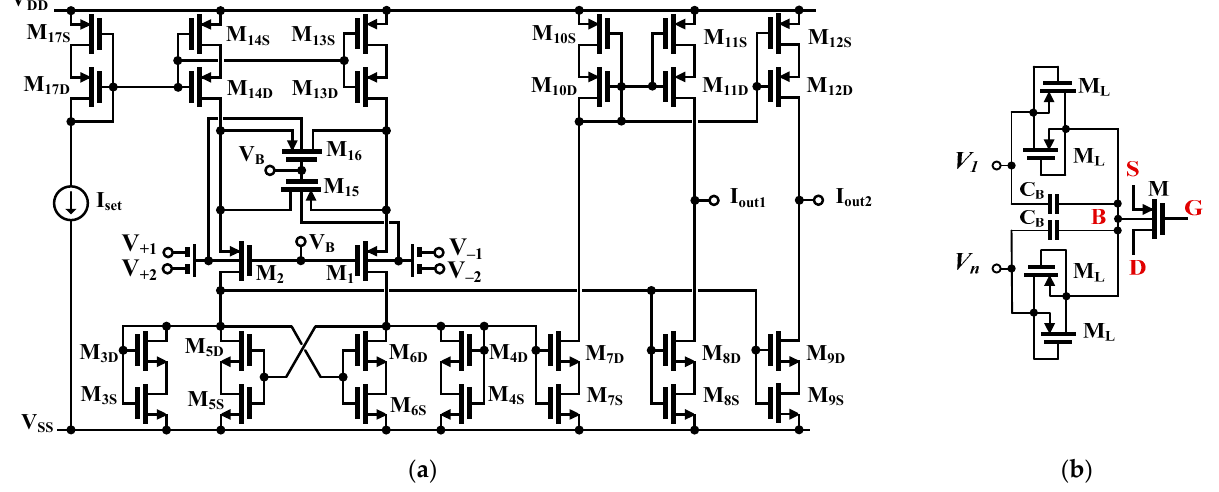
Figure 2. CMOS implementation of proposed MI-OTA: ( a ) schematic, and ( b ) bulk-driven MI-MOST technique.